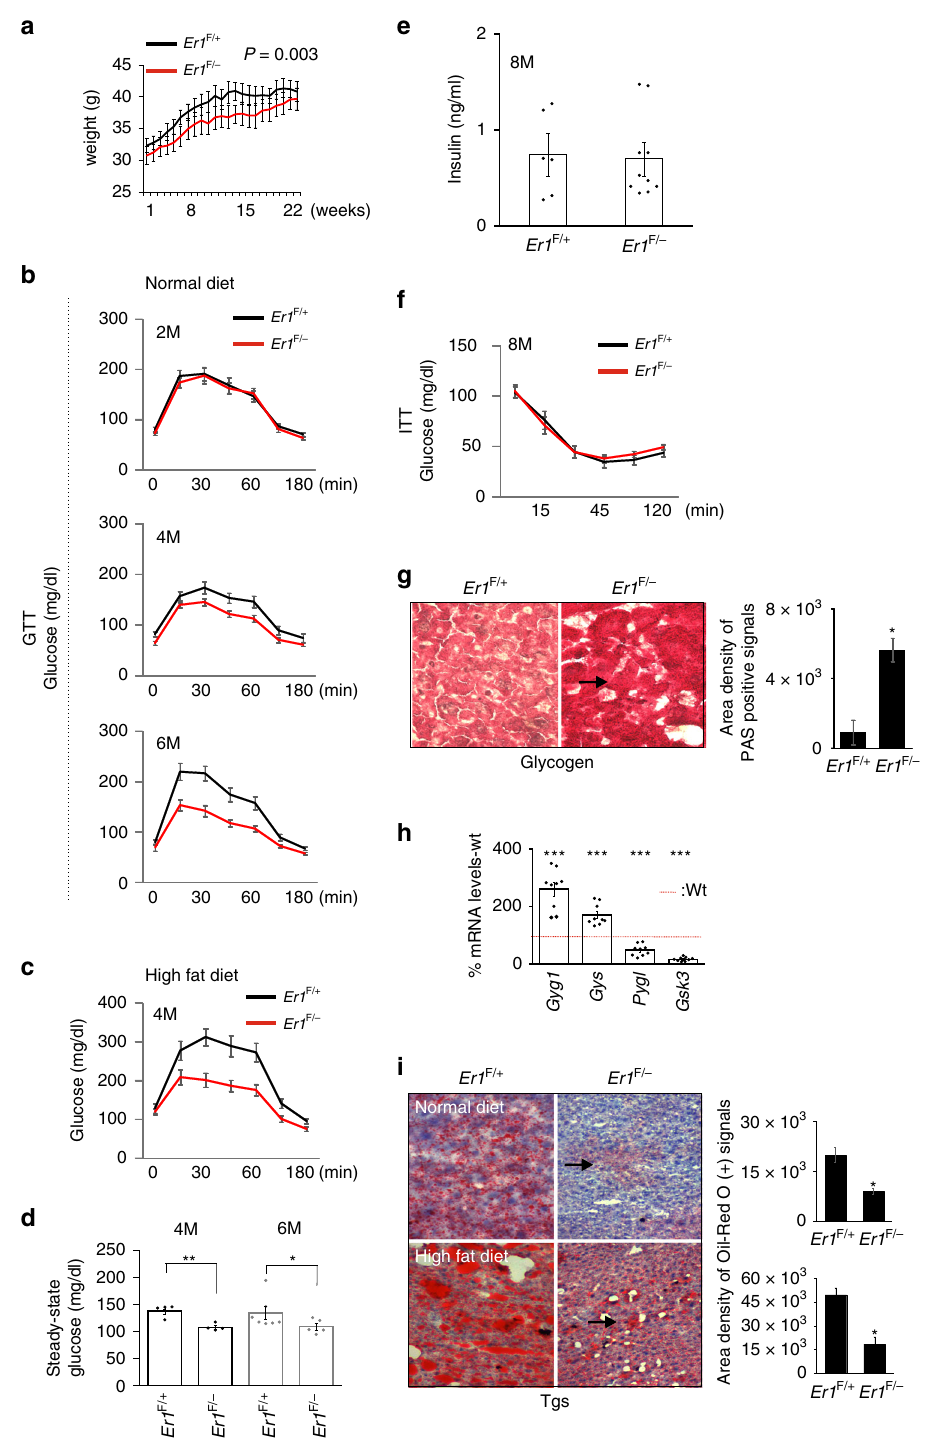
Fig. 3 The ERCC-XPF defect in macrophages triggers metabolic changes in Er1 F/ − mice. a Weights curves of 2-months-old Er1 F/ − and Er1 F/ + animals ( n = 8) over a period of 22 weeks. b Glucose tolerance test (GTT) graphs of 2-months-old Er1 F/ − and Er1 F/ + mice fed on a normal diet for a period of 2-, 4-, and 6-months (M), as indicated. c GTT graphs of 2-months-old Er1 F / − and Er1 F + mice ( n = 10) fed on a high-fat diet for a period of 4 months (M). d Steady-state glucose serum levels of 4- and 6-months (M) old Er1 F/ − and Er1 F/ + mice after 2 h of fasting ( n = 8). e Insulin serum levels of 8-months (M) old Er1 F/ − ( n = 10) and Er1 F/ + ( n = 7) mice ( f ) Insulin tolerance test (ITT) graphs of 8-months (M) old Er1 F/ − and Er1 F/ + mice ( n = 8). g Representative periodic acid – Schiff (PAS) staining and quanti fi cation (3 optical fi elds per animal) of glycogen in Er1 F/ + and Er1 F/ − livers ( n = 4 animals per genotype). h Gyg1 , Gys , Pygl , and Gsk3 mRNA levels in Er1 F/ + (red dotted line) and Er1 F/ − livers. i Representative Red-oil staining and quanti fi cation (three optical fi elds per animal) of triglycerides in the liver of Er1 F + and Er1 F/ − mice ( n = 3) fed on normal or high fat diet (as indicated); arrowhead indicates the decrease in